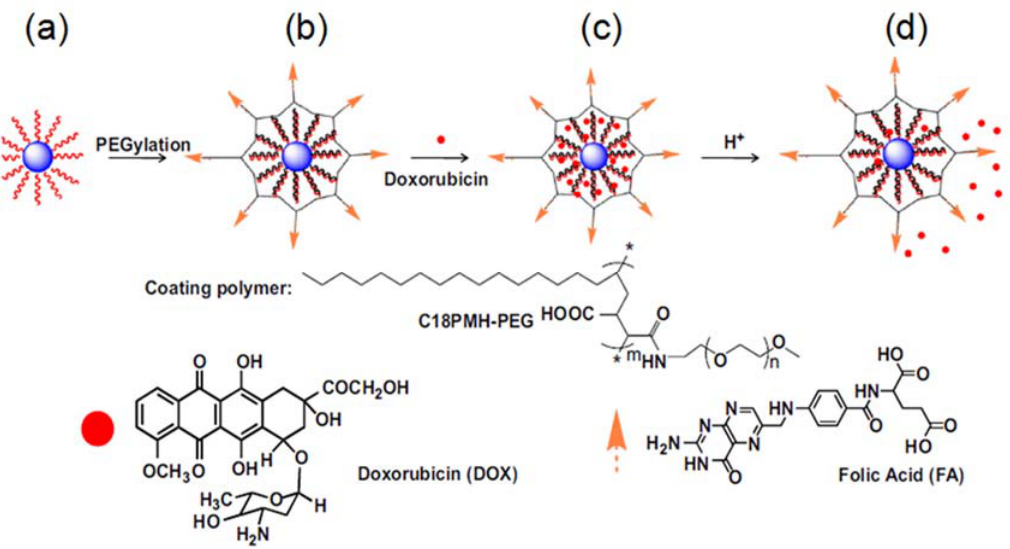
Figure 9. Schematic illustration of the UCNP-based drug delivery system. ( a ) As-synthesized oleic acid capped UCNPs; ( b ) C18PMH-PEG-FA functionalized UCNPs; ( c ) DOX loading on UCNPs. DOX molecules are physically adsorbed into the oleic acid layer on the nanoparticle surface by hydrophobic interactions; ( d ) Release of DOX from UCNPs triggered by decreasing pH. Reproduced from [110]. Copyright 2011, Elsevier